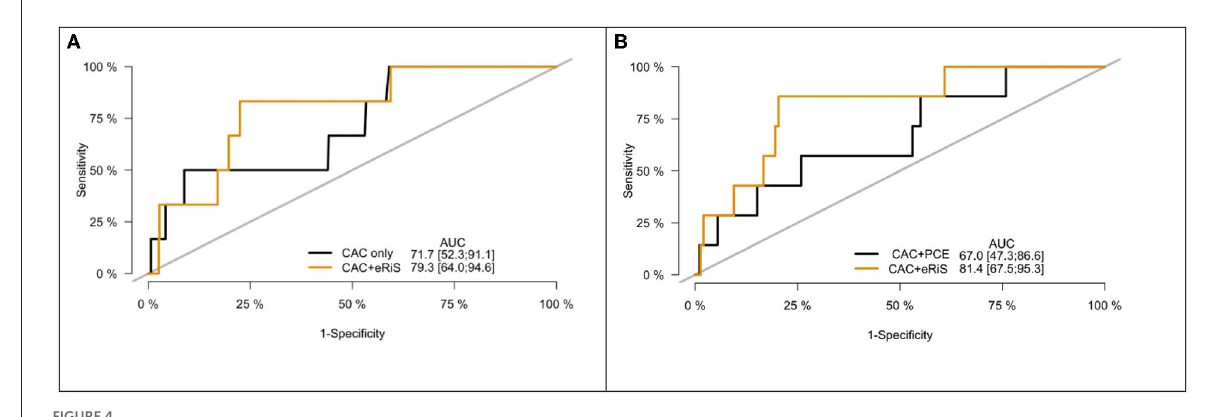
FIGURE4 Receiver operating characteristic (ROC) curve for CAC only vs. eRiS + CAC shows the benefit of adding eRiS to CAC for better prediction of the probability of a MACE event in (A) . CAC + eRiS showed better performance than CAC + PCE (C-index: 0.72 vs. 0.67) for patients who had PCE available in (B) .